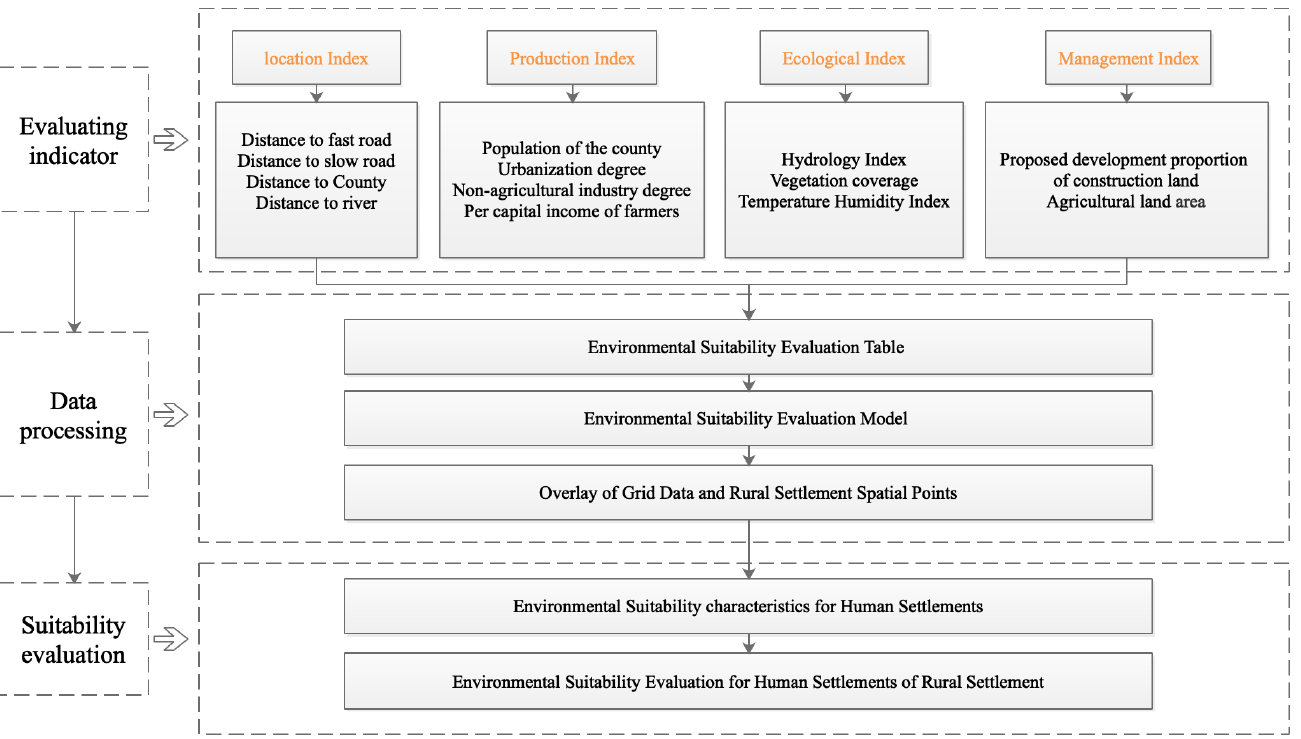
Figure 2. Research flow